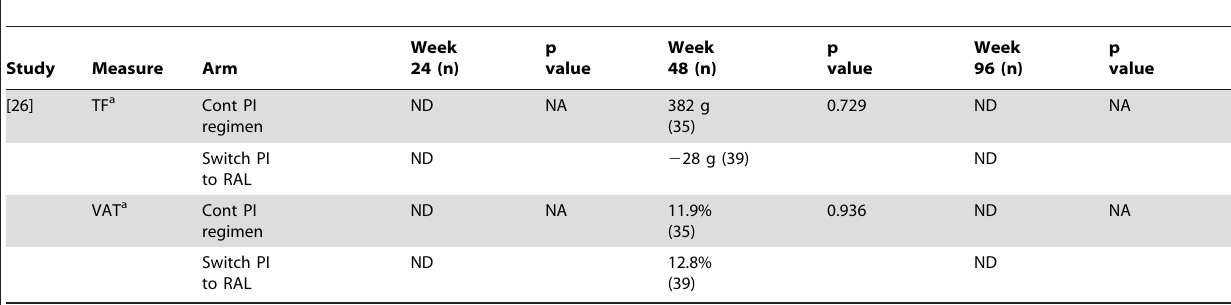
Table 26. Switching studies: change from baseline in trunk fat (TF) on DEXA scan and visceral adipose tissue (VAT) on CT scan: PI versus